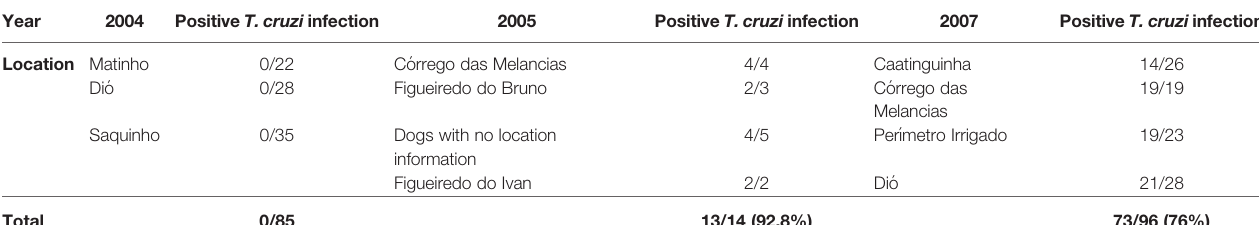
TABLE 3 | Trypanosoma cruzi infection of dogs demonstrated by serological exams from Jaguaruana municipality, Ceara ́ state,